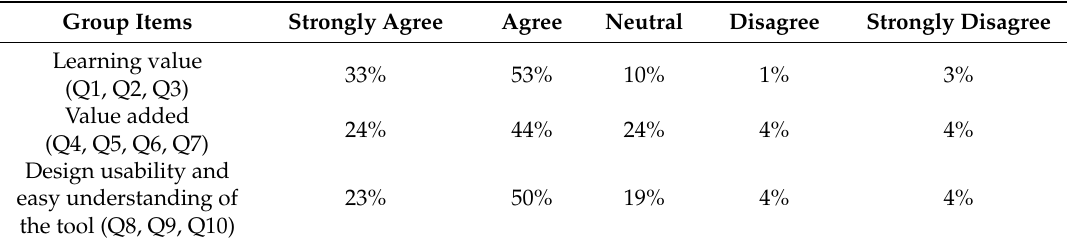
Table 8. Students’ responses to the tool survey (number of students = 45).